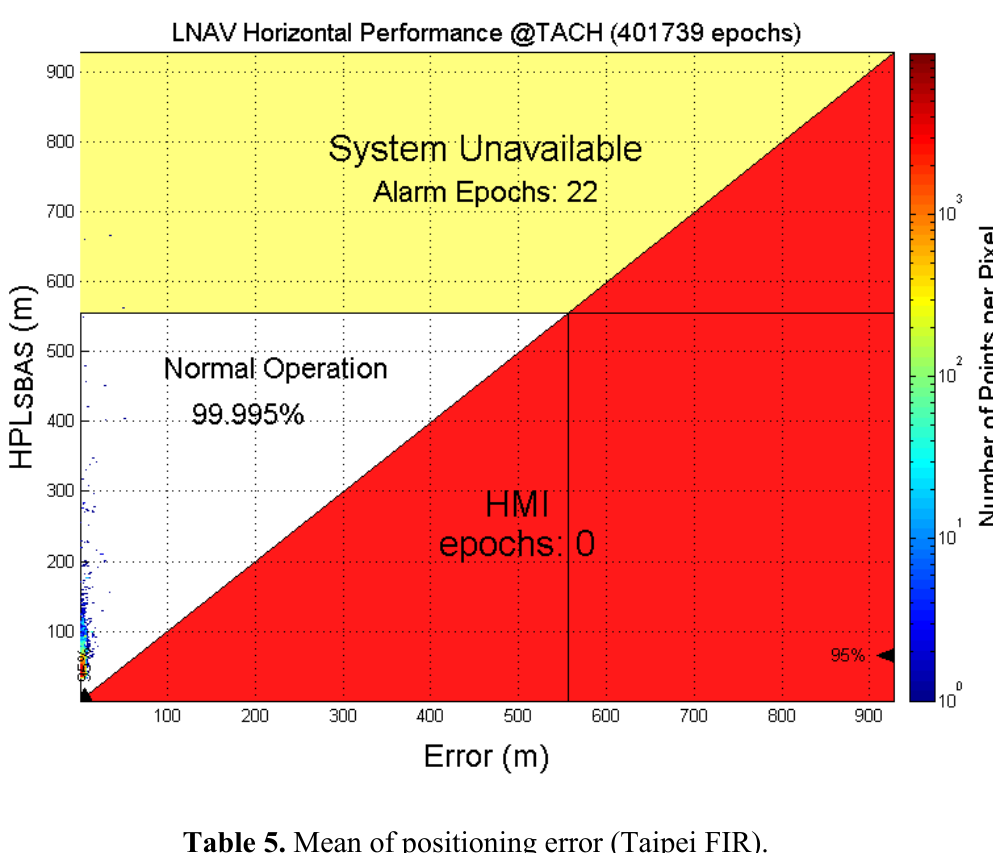
Figure 27. The LNAV (NPA) performance of the developed WADGPS with 4 RSs in Taipei FIR.